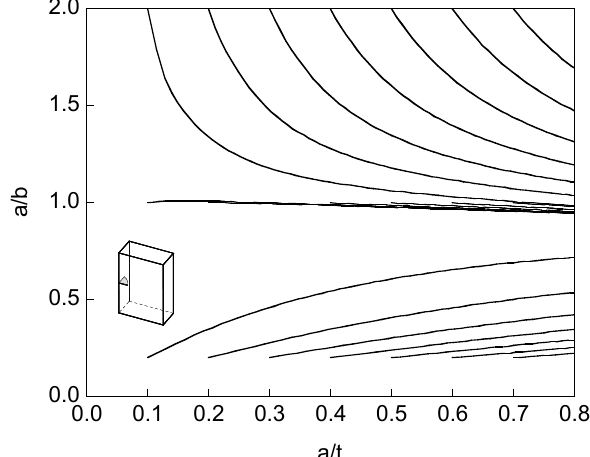
Figure 6. Crack aspect ratio evolution during corrosion fatigue propagation for cracks emanating from a plate corner.